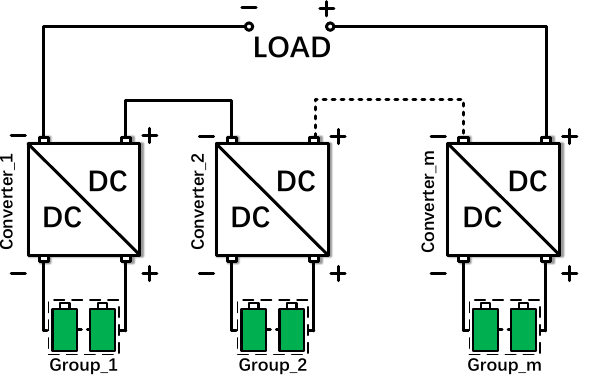
Figure 5. Topology of outer layer.